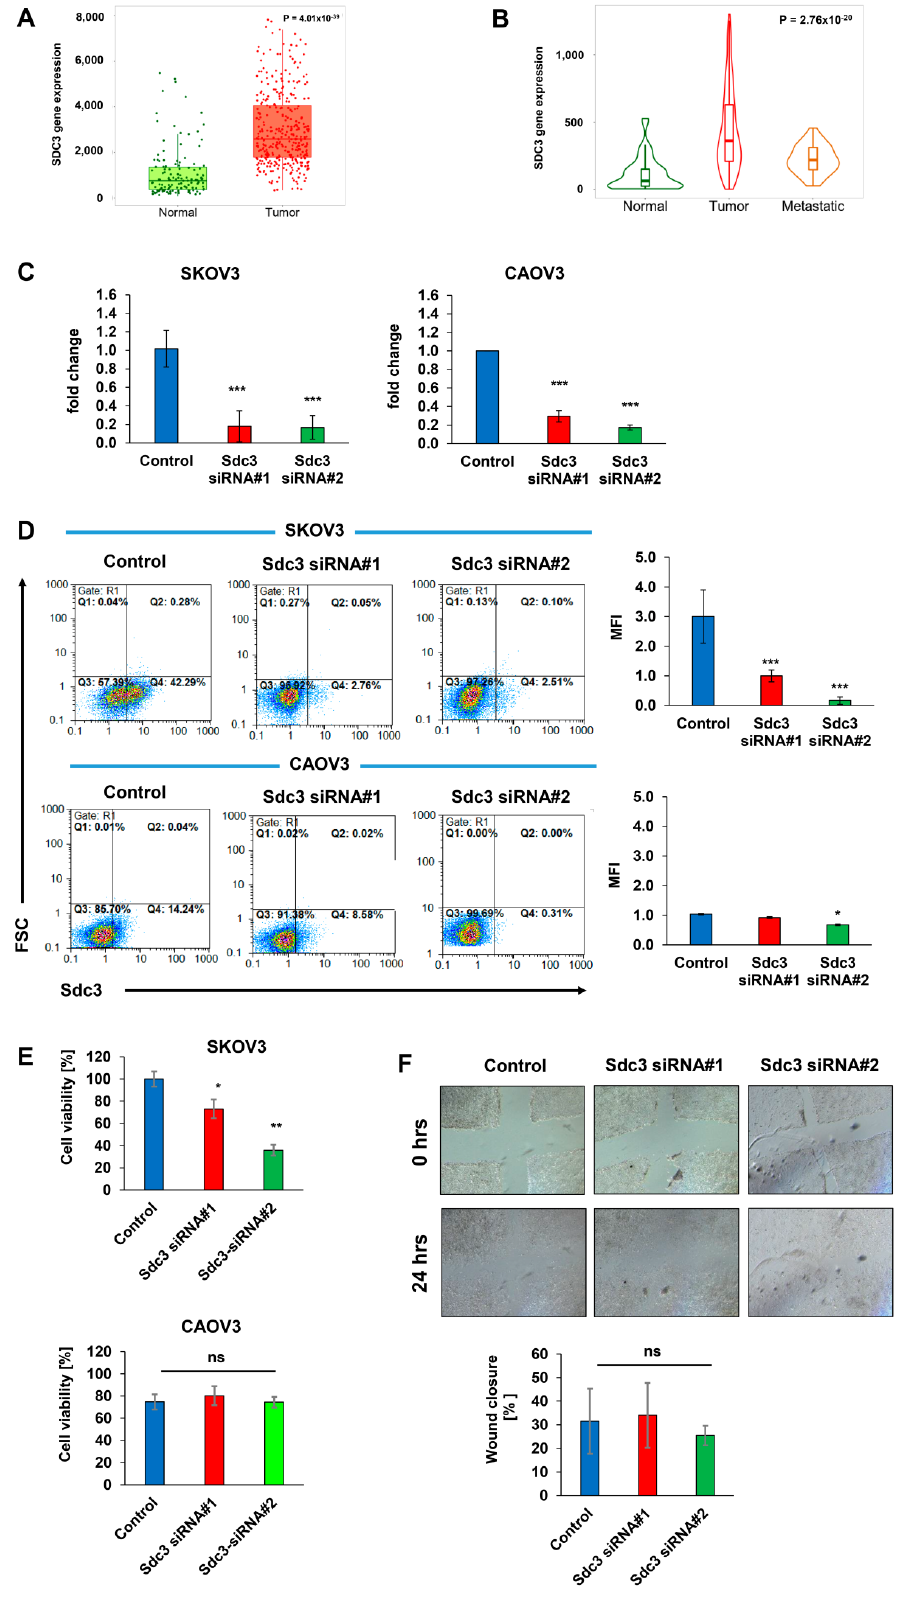
Figure 1. Syndecan-3 is upregulated in ovarian cancer tissues and regulates cell viability. ( A ) Syndecan-3 (SDC3) mRNA expression as analyzed by RNASeq is significantly higher in ovarian serous cystadenocarcinoma tissue ( n = 374) compared with control tissue ( n = 133), p = 4.01 × 10 − 39